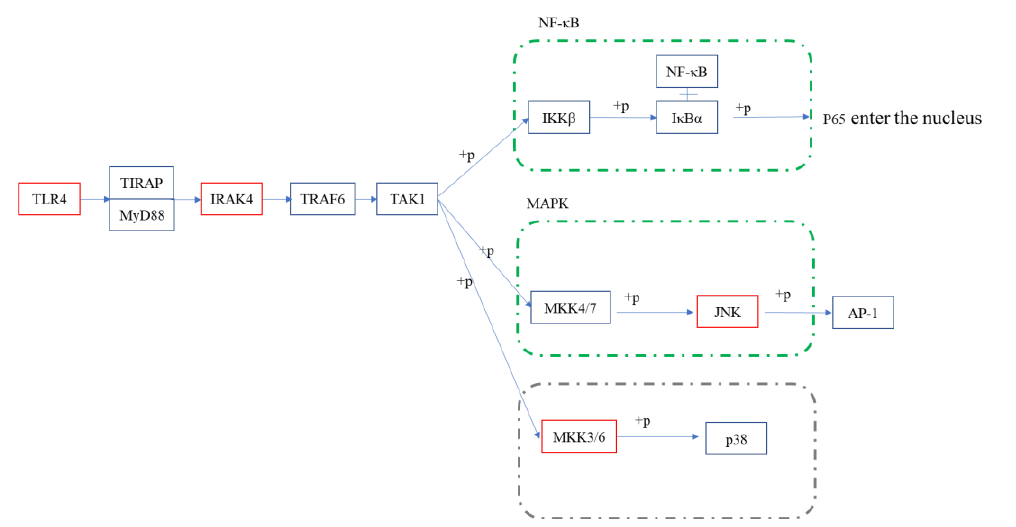
Figure 9. Schematic diagram of Toll-like receptor signaling pathways in the EG/LPS group. Red represents significant upregulation; p38 pathway is marked as gray because no significant change was detected.